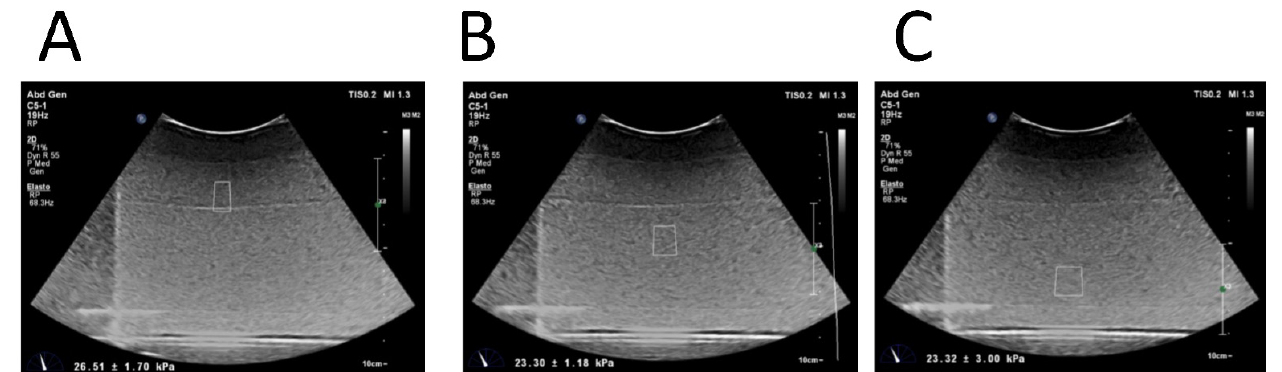
Figure 2. pSWE measurements of background within an elasticity quality assurance phantom (Model 049, CIRS). pSWE were obtained in kPa using EPIQ7 ultrasound imaging systems at different depths (i.e., three cm ( A ), five cm ( B ), and seven cm ( C )) with the use of medium penetration, gain of 71% and image depth was set at 10 cm. The pSWE region of interest (ROI) was fixed and un-adjustable having an approximate diameter of one cm.